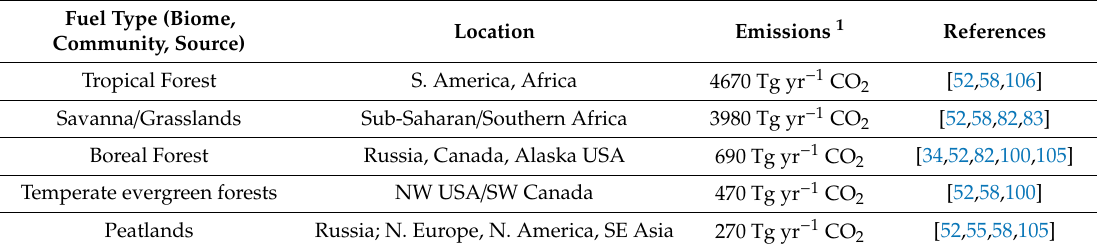
Table 1. Five examples of wildland fuels considered according to the “Magnitude of fire emissions” criterion. Fuels are listed with dominant or common global locations of occurrence, and information on total emissions (generally either total C or CO 2 , depending on